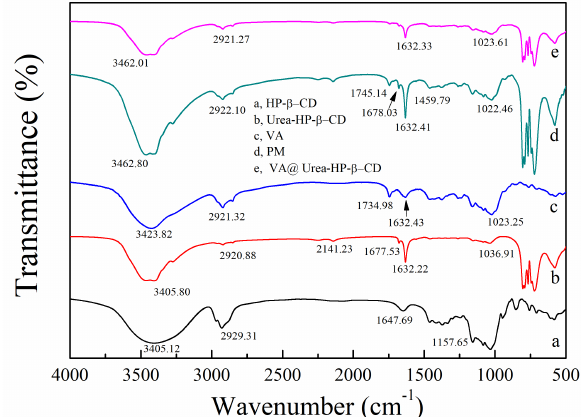
Fig. 3. Infrared spectroscopy of (a) HP- β -CD (b) Urea-HP- β -CD (c) VA (d) PM (e) VA@ Urea-HP- β -CD.